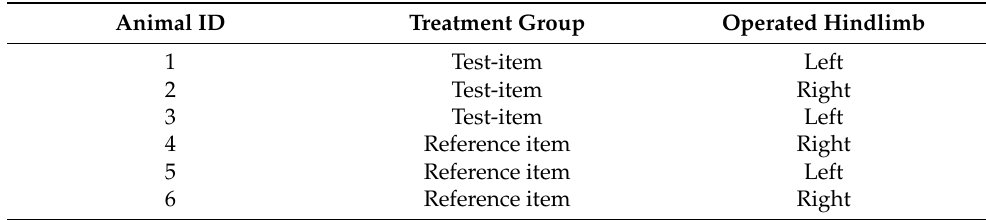
Table A1. Allocation table for rabbits included in the GLP preliminary safety study of hFPTs in a partial-thickness model of patellar tendon defect. GLP, good laboratory practice; hFPT, human fetal